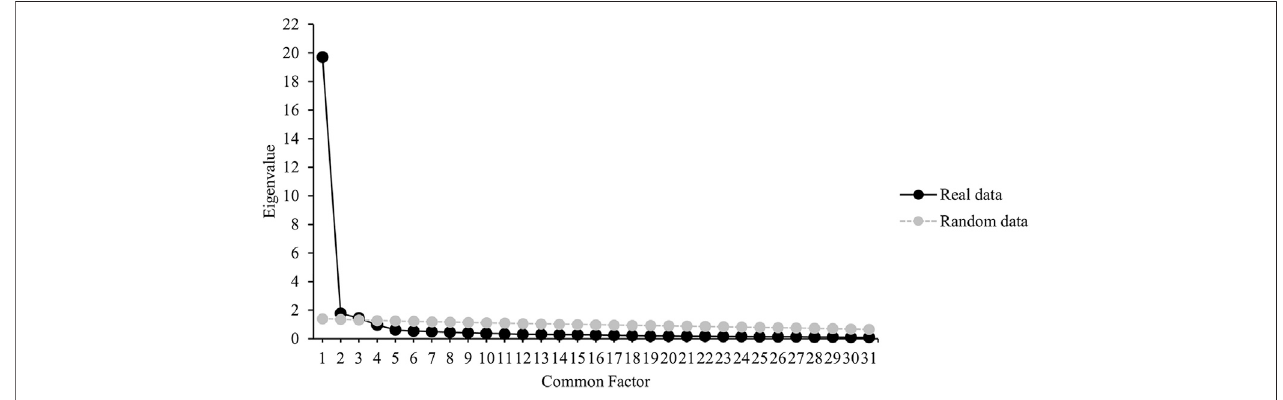
FIGURE 1 | Eigenvalues from real data and random data. Note . Black dots represent eigenvalues obtained from real data, and gray dots represent eigenvalues averaged across 200 random data